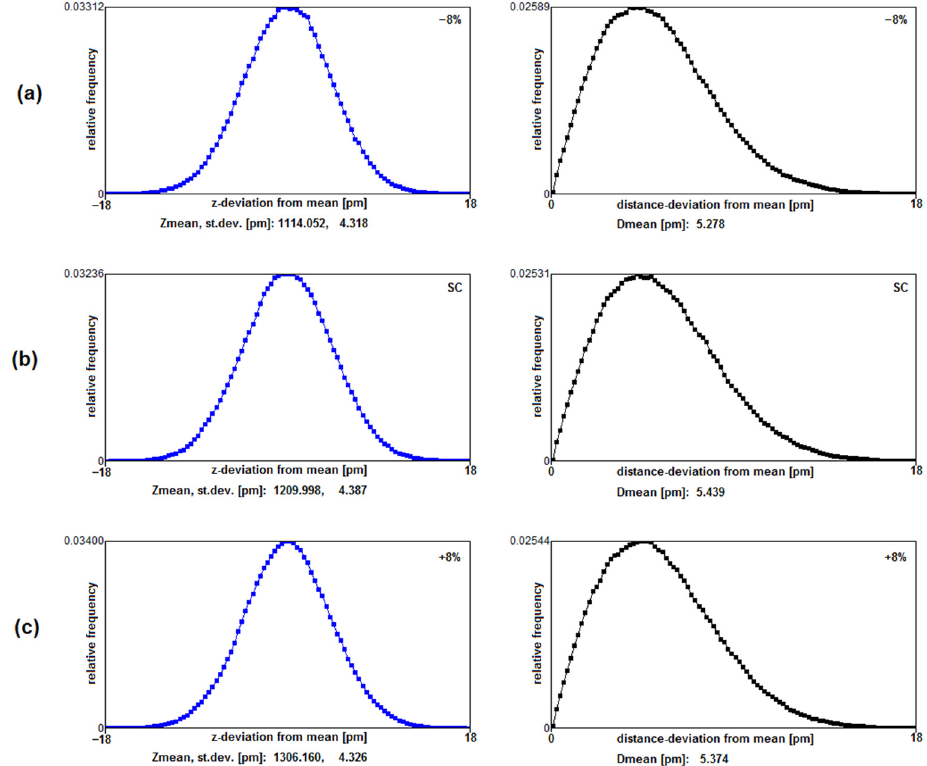
Figure 6. ( a – c ) Frequency distributions for z-deviations from mean oxygen locations and total distance deviations from mean oxygen locations of the Tyr78 carbonyl oxygen (the lower boundary of location S0) for a K0W1K2W3K4 configuration. Results for standard distances of the filter are given in ( b ), and those for 8% shorter or longer filter in ( a , c ), respectively.